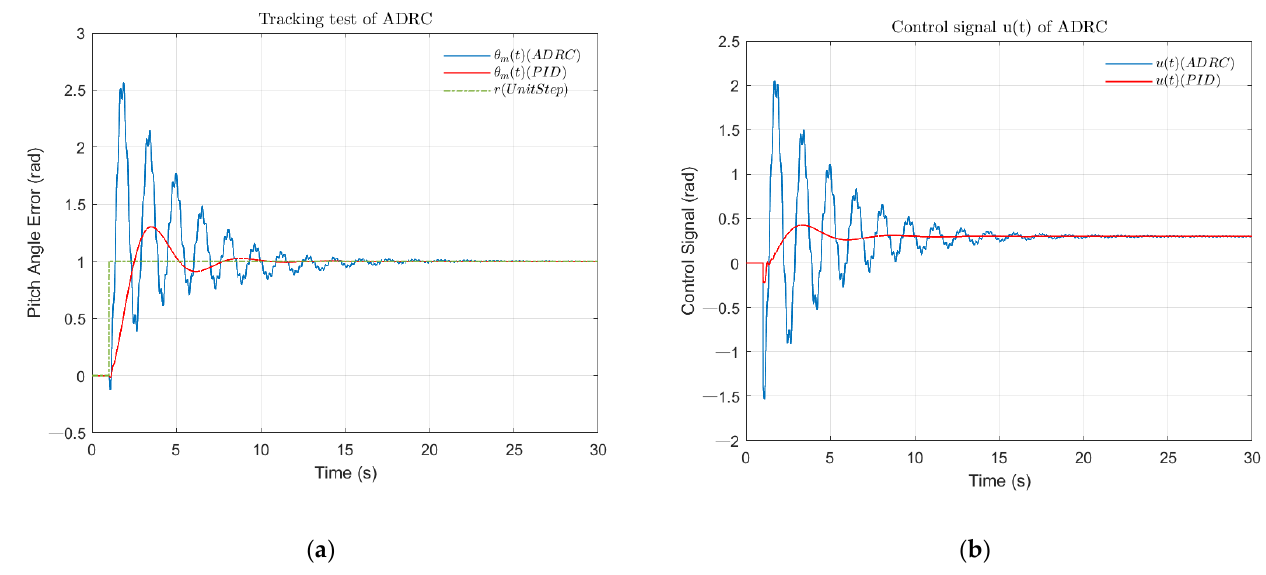
Figure 5. Comparison of the control effects of ADRC and PID controller (tracking test). ( a ) The simulation result of pitch angle of aircraft dynamic model under unit step signal; ( b ) The simulation result of control signal of aircraft dynamic model under unit step signal.